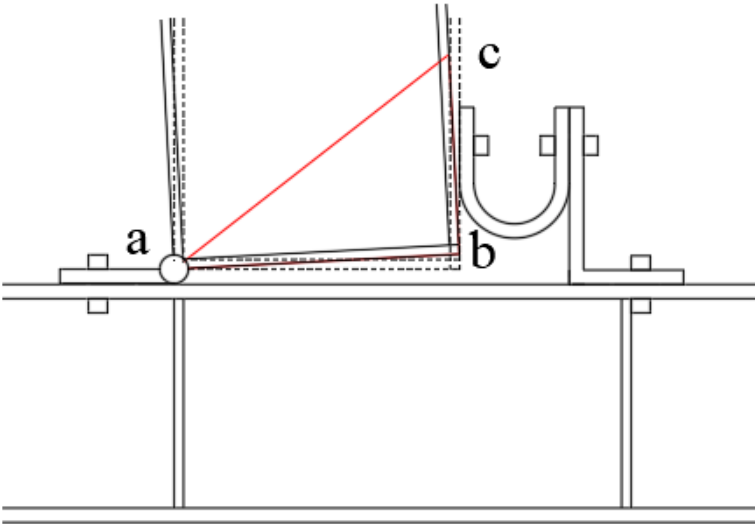
Figure 7. Connection deformation.